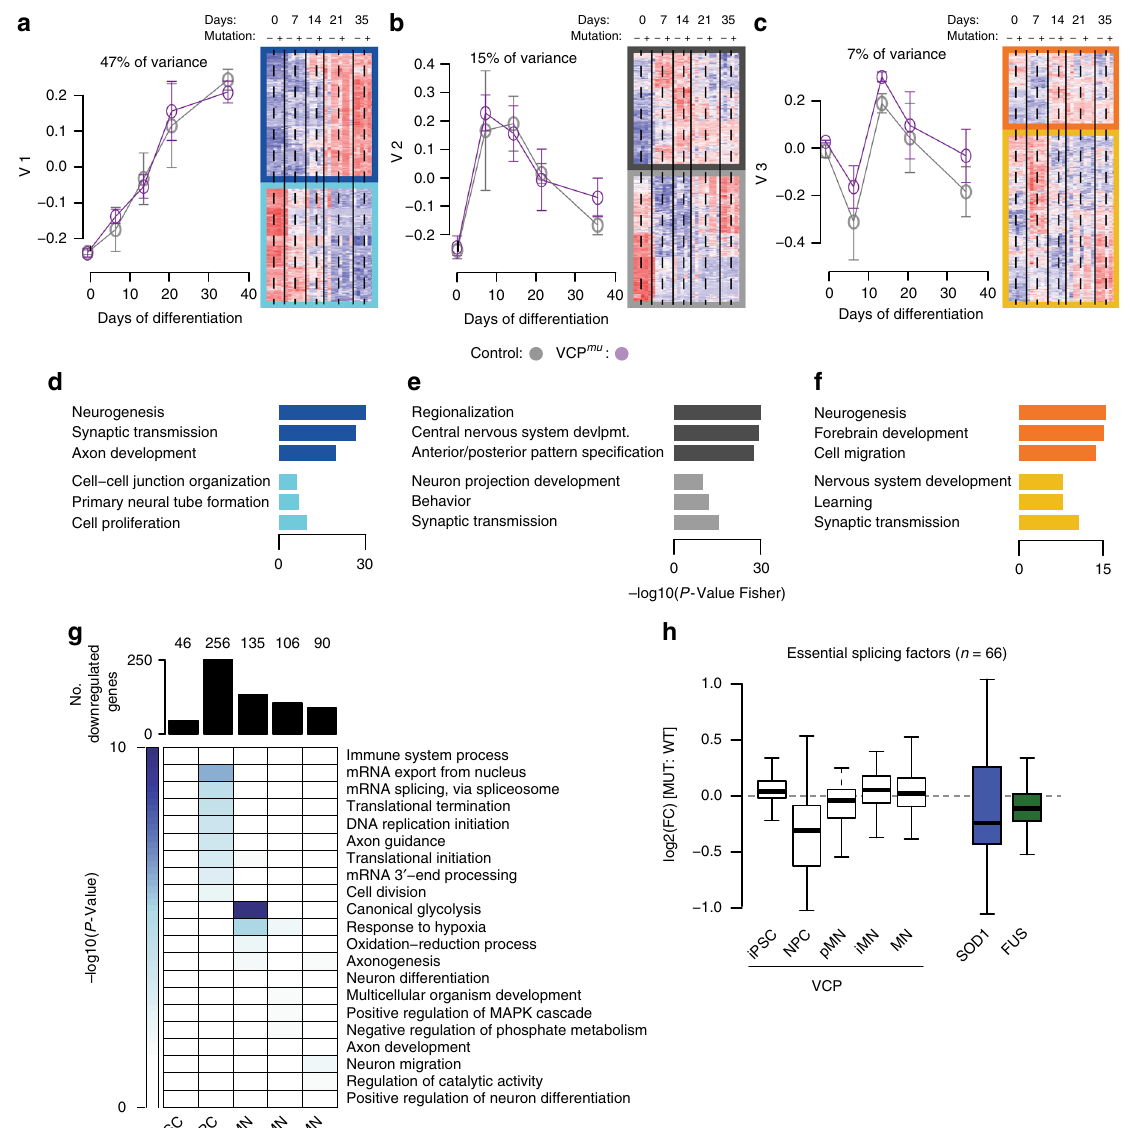
Fig. 4 Global downregulation of splicing components coincides with IR. a – c Singular value decomposition analysis of the expression of 15,989 genes in n = ! v ! 31 samples. Left, Line plots showing the expression pro fi les of the fi rst three singular vectors v 1 through 3 , capturing 47%, 15% and 7% of the variance in gene expression, respectively. Grey and magenta data points indicate expression for the control and VCP mu samples. Right, heatmap of the standardised expression of genes whose expression pro fi les correlate positively (indicated by top three darker rectangles) and negatively (indicated by bottom three lighter rectangles) with the fi rst three right singular vectors. d – f Bar plots displaying the enrichment scores for GO biological functions of genes that correlate positively (top three bars) or negatively (bottom three bars) with the fi rst three right singular vectors. g Upper, bar plots depicting the numbers of downregulated genes in VCP mu samples compared with control at distinct stages of MN differentiation. Lower, heatmap of the GO biological functions enriched among downregulated genes at the corresponding time-points. h Boxplots showing the distributions of log2 fold-changes for 66 essential splicing factor genes between ALS mutants and controls; white boxes = VCP mu compared with controls, blue box = SOD1 mu compared with isogenic controls, green box = FUS mu compared with